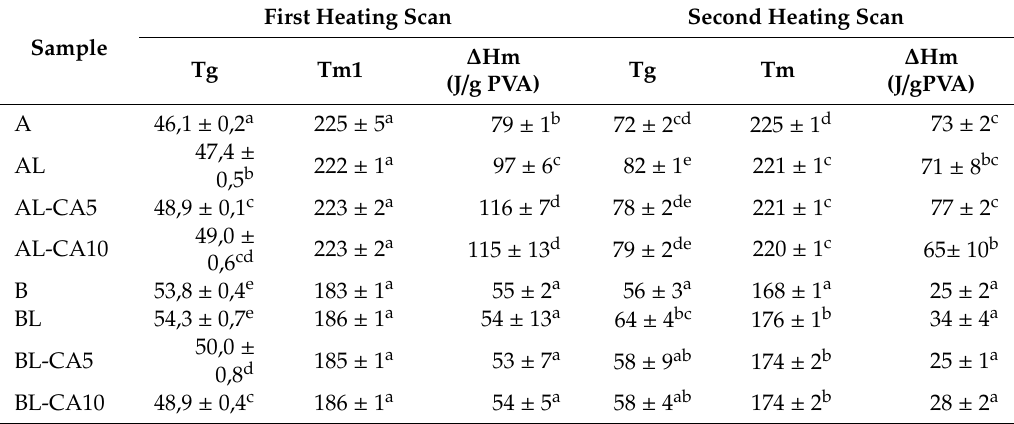
Table 2. Glass transition and melting temperature and enthalpy of the PVA films (A and B). First Heating Scan Second Heating Sample